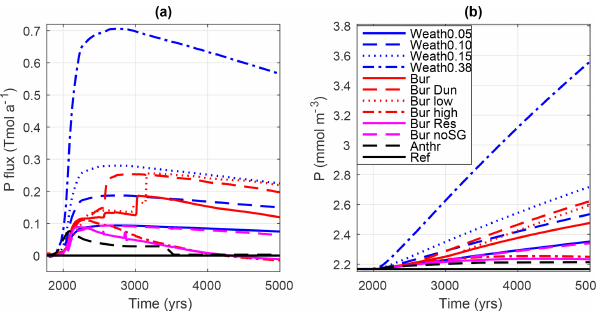
Figure 1. Globally integrated pre-industrial P weathering fluxes in TmolPa − 1 from field studies (red) and the range of pre-industrial P weathering fluxes covered by all simulations (blue with bars indicat- ing the range; see W P , 0 in Table 1). Estimates from field studies are based on literature values for global fluvial fluxes of bioavailable P and the error bars denote upper and lower limits of these estimates.